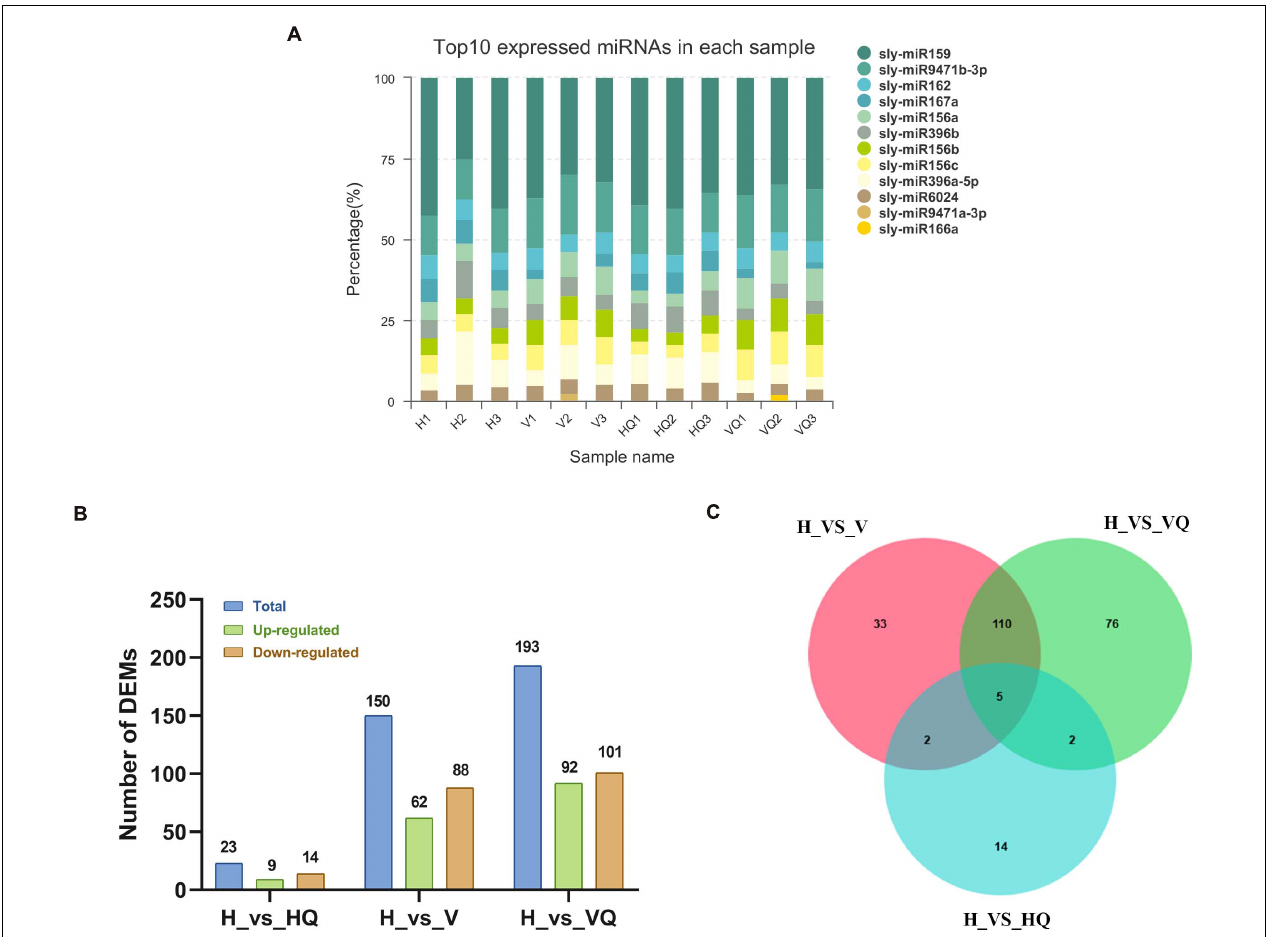
FIGURE 8 | The expression profile of differentially expressed miRNAs at different treatment. (A) Top expressed miRNAs in each sample. (B) Up- and down-regulated differentially expressed miRNAs. (C) The Venn diagram of differentially expressed miRNAs. H, healthy tomato plants. HQ, tomato plants was fed on by healthy B. tabaci for 24 h. V, tomato plants was inoculated with ToCV. VQ, tomato plants with ToCV that were fed on by healthy B. tabaci for 24